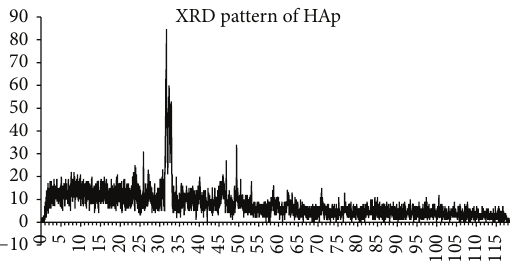
Figure 2: The XRD pattern of synthesized HAp.